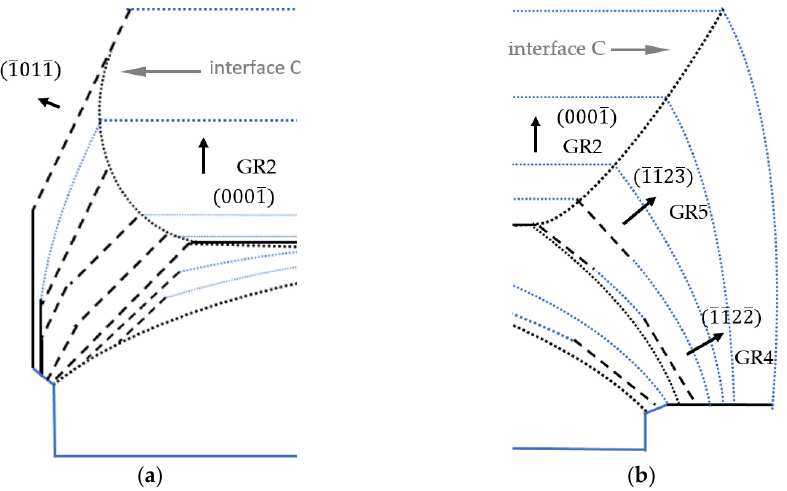
Figure 13. Predicted behavior of interface C for a longer growth process and the resulting shape of the crystal: ( a ) view on the (12(cid:3364)10) plane and ( b ) view on the (1(cid:3364)100) plane. the crystal: ( a ) view on the